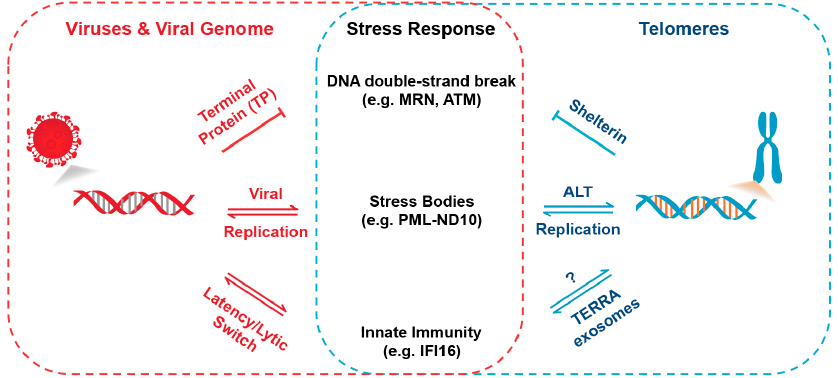
Figure 5. Common stress pathways regulating virus infection and telomeres. Comparison highlighting some common mechanisms used by viruses and telomeres to suppress and/or co-opt DDR and genome maintenance machinery.